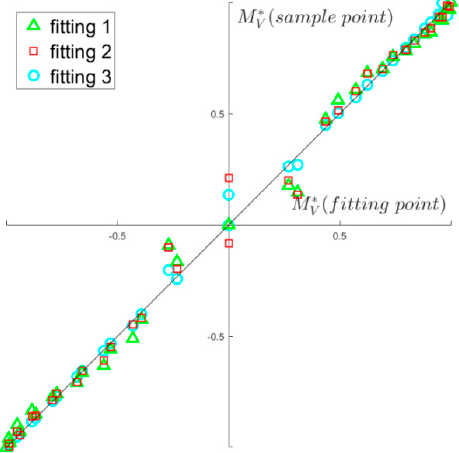
Figure 26. The case of a damaged hull due to stranding.